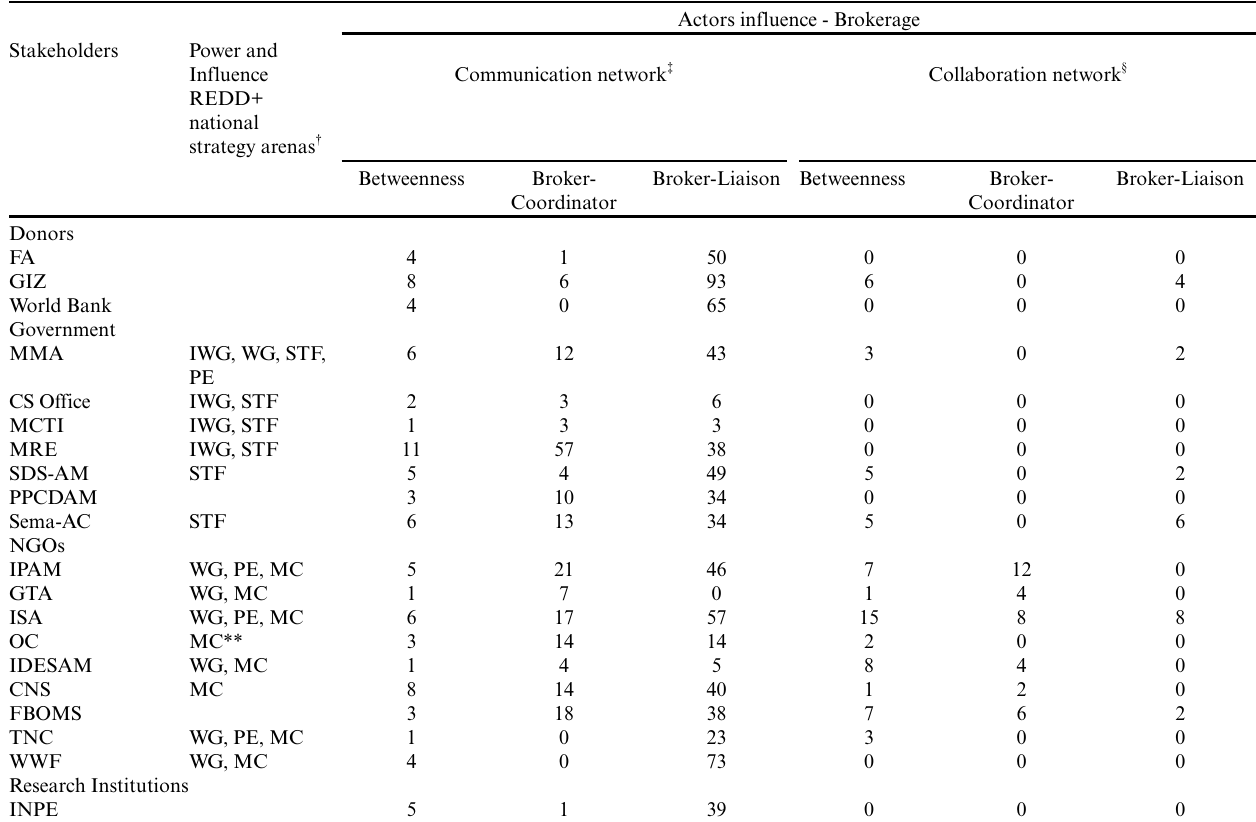
Table 2 . Brokerage measure of policy